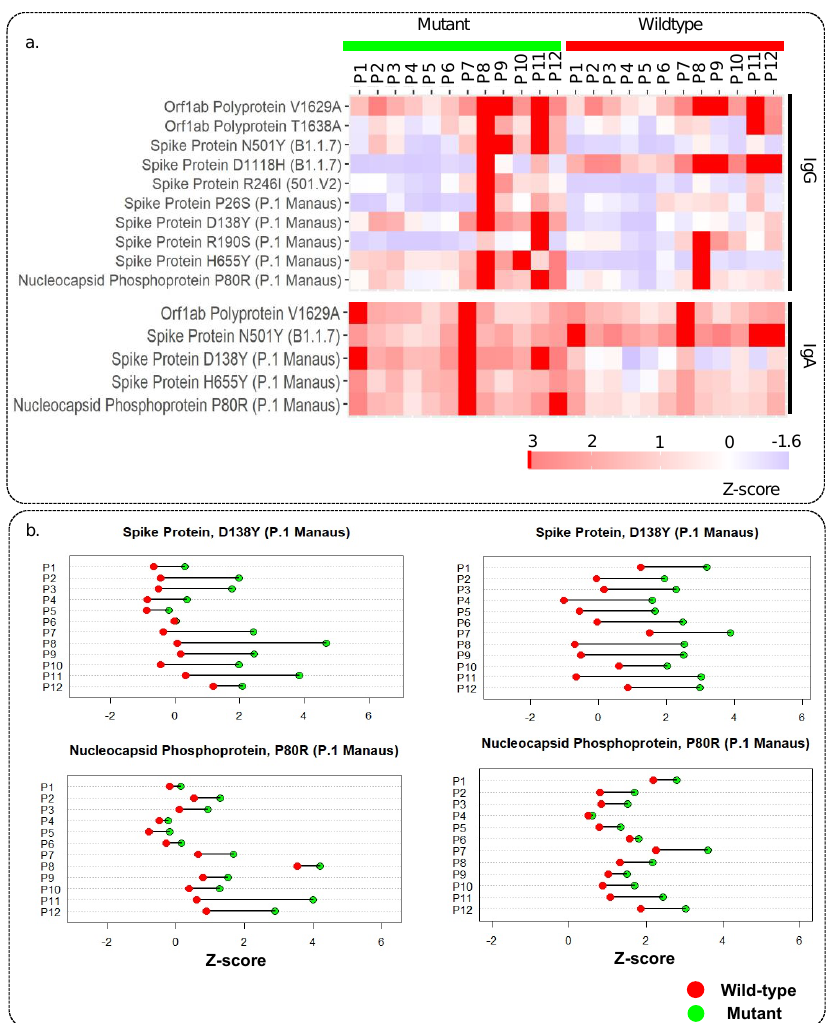
Figure 4. Immune response against mutant peptides for IgG and IgA: ( a ) Heatmap showing IgG and IgA response for peptides with mutations from different SARS-CoV-2 variants and their wildtype counterpart, ( b ) representative dot plots showing the patient-wise comparison of response against mutant and wildtype peptides.